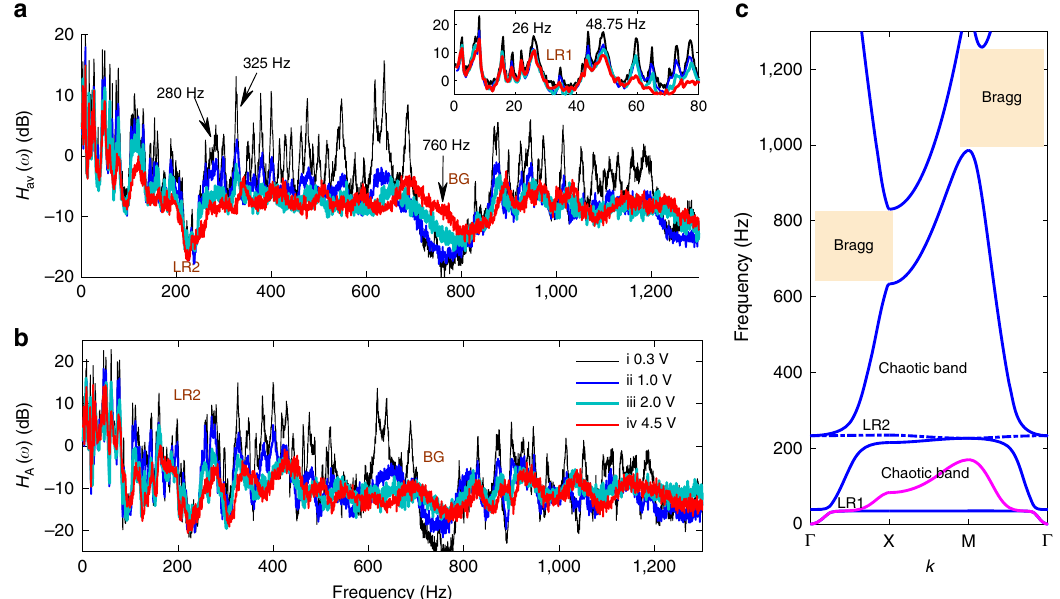
Fig. 5 Transfer functions and dispersion of the NAM plate. Excitations are broadband white noises. Four driving levels are (i: 0.3 V, 3.2578 × 10 − 3 mm, σ = 0.0067 ≈ 0); (ii: 1.0 V, 1.5748 × 10 − 2 , σ = 0.157); (iii: 2.0 V, 3.2509 × 10 − 2 , σ = 0.669); (iv: 4.5 V, 7.1242 × 10 − 2 , σ = 3.21). a Average transfer function H ω ) of the 13 × 13 scanning points; the iconograph is the enlarged view near LR1. b Transfer functions of point A, H av ( c Dispersion curves of the 2D metamaterial plate considering only the Duf fi ng oscillator; blue curves: LAM; and magenta line: NAM solved with perturbation approach with displacement amplitude in case iii, other curves are superposed with blue curves (see Methods). k denotes the wave vector of the fi rst Brillouin zone (see Fig. (linear) to σ = 3.21 (strongly nonlinear). The average transfer P N H i ð ω Þ = N , where N = 169. function is H av ð ω Þ ¼ i ¼ 1